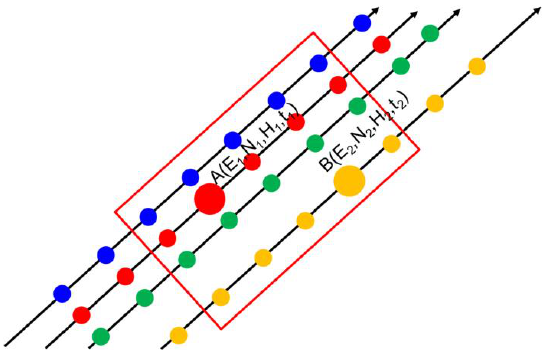
Figure 3. Sketch map of the planes fitted to ground tracks of GLAS. Different colors of footprints denote different tracks. The points A and B are enlarged footprints characterized by their coordinates ( E , N , H ) and acquisition time ( t ). The red window shows the sampled facet.